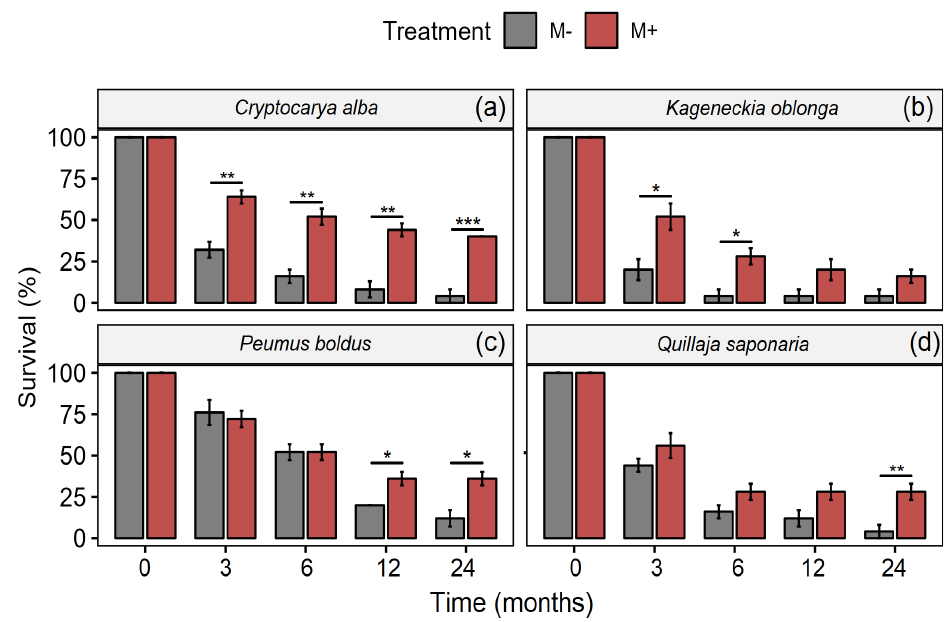
Figure 1. Survival in C. alba ( a ), K. angustifolia ( b ), P. boldus ( c ), and Q. saponaria ( d ), four dominant woody plant species from the Chilean Mediterranean ecosystem (MTE), after a fire with (red bars) and without (grey bars) inoculation with AMF. Values represent means (±1SE). Significant differences (pairwise t -test; Bonferroni correction) between treatments are represented with * p < 0.05; ** p < 0.01; *** p < 0.001. Table 2. Results of two-way repeated measures ANOVA for photosynthesis for the four tree species. Main factors: Time, AMF treatments, and their interaction. Degrees of freedom (d.f.), F-values, and p -values are shown. Species